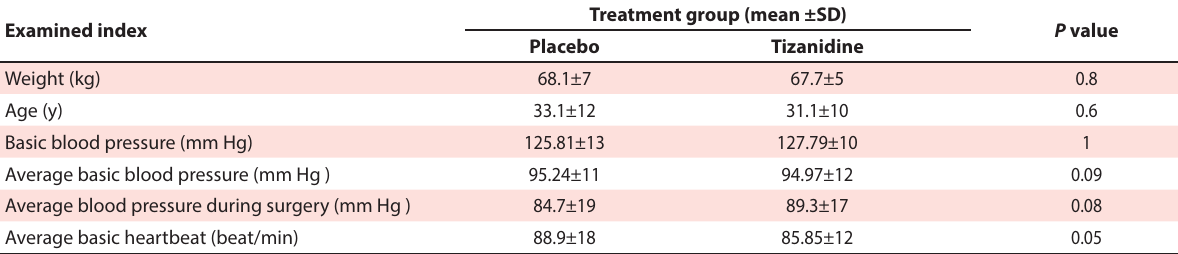
Table 1. Comparison of general indexes in both groups